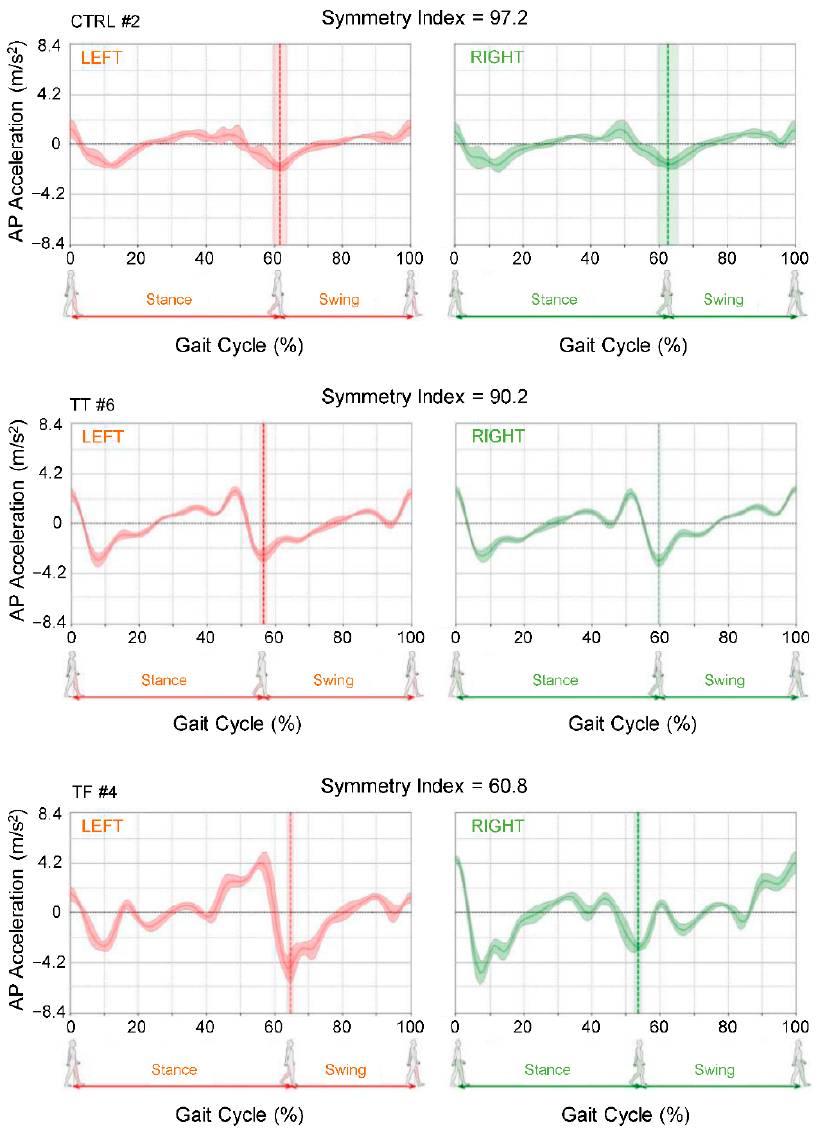
Figure 2. Representative examples of anterior–posterior (AP) body acceleration during gait cycle performed on the left and right sides by one control participant (CTRL), one transtibial amputee (TT), and one transfemoral amputee (TF). The waveforms represent the means and the standard deviations of AP accelerations from the total number of cycles during the 10-m walk test. The linear correlation between the left and the right AP accelerations, estimated by the Pearson correlation coefficient, was the basis for the gait cycle symmetry index (see Section 2 for details).